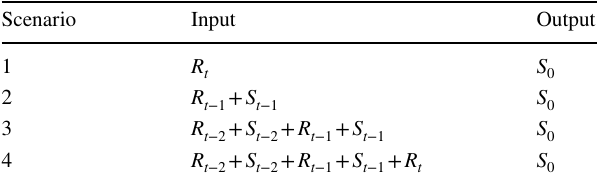
Table 2 Basis of the equations for all four scenarios of the forecasting models